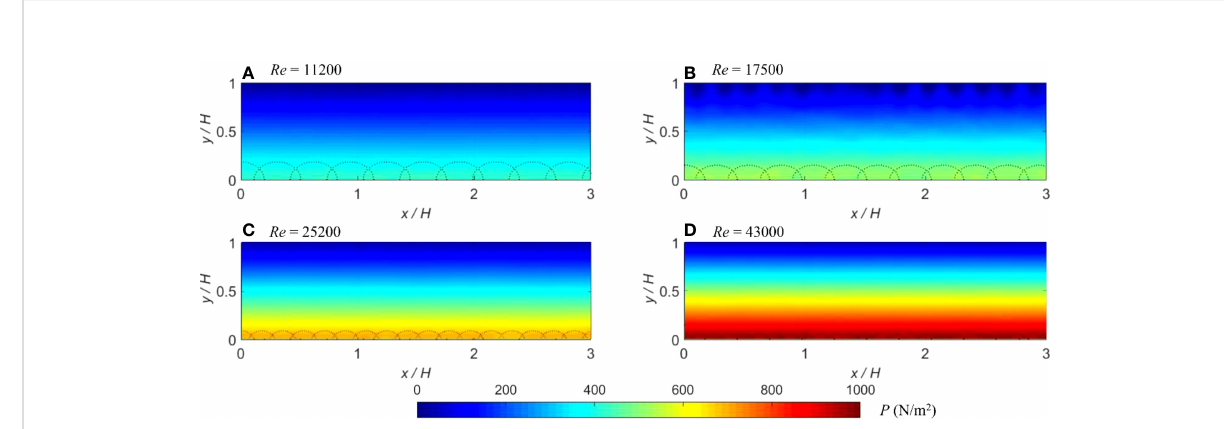
FIGURE 3 (A – D) Longitudinal contours of computed time-averaged pressures at the fl ume centerline for different fl ow conditions. The dashed semicircles at the bottom of each panel represent the rough bed spheres.